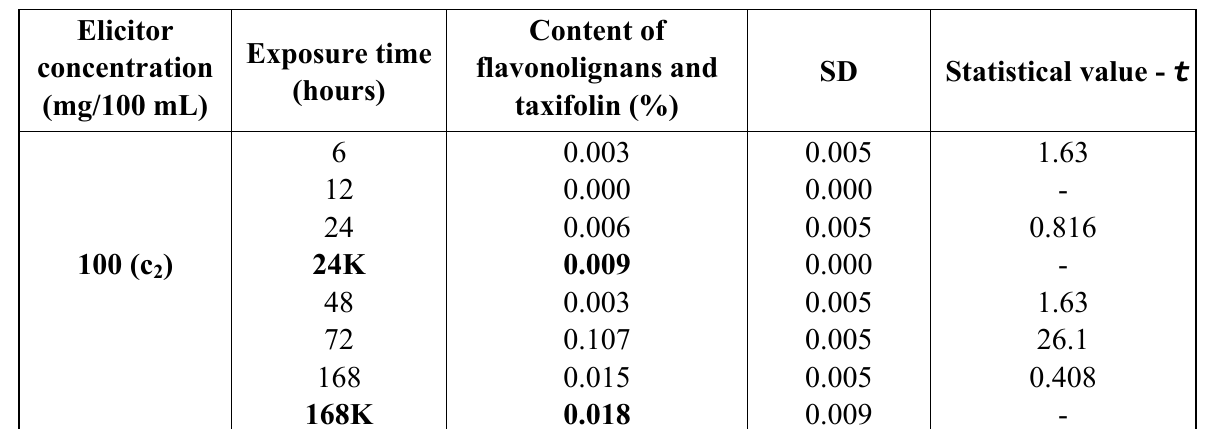
Table 2. Flavonolignans and taxifolin content (%) in callus culture S. marianum L. after elicitation with compound 2